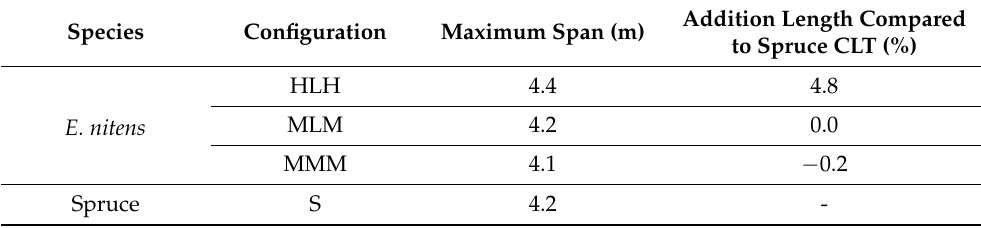
Table 8. Comparison of the maximum spans between E. nitens and Spruce CLT